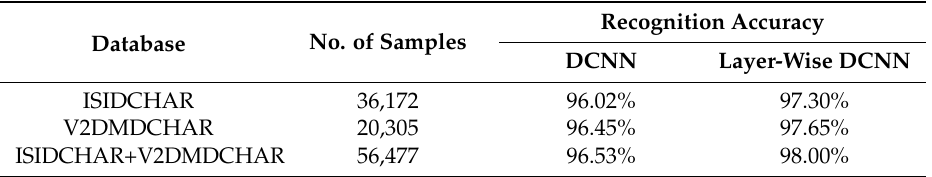
Table 6. In this table, we reported the maximum recognition accuracy obtained with NA-6 and RMSProp optimizer on ISIDCHAR, V2DMDCHAR and combined both when the model was trained layer-wise.